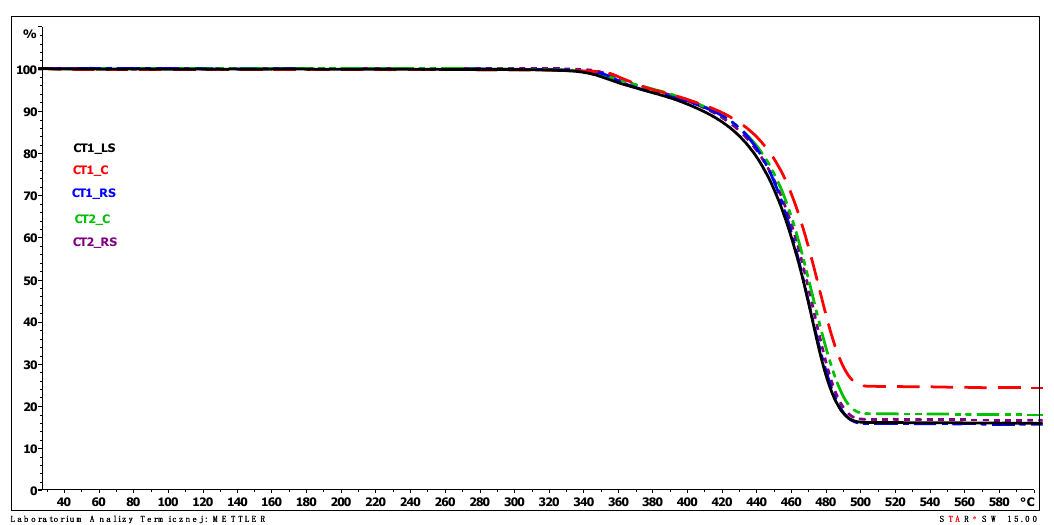
Figure 15. TGA curves of tested samples.